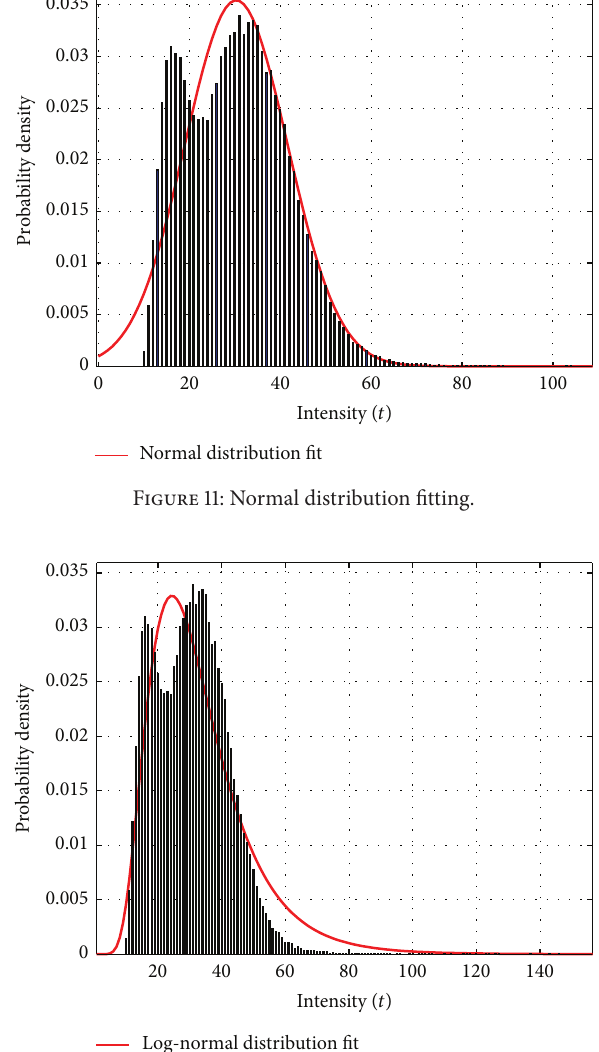
Figure 12: Log-normal distribution